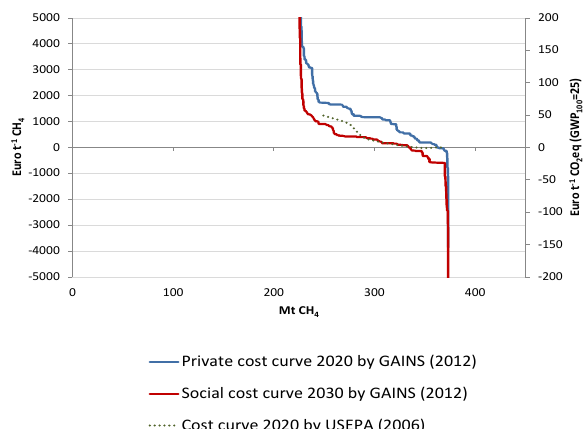
Fig. 6. Global CH 4 mitigation cost curve 2020 with private and so- cial cost perspectives and in comparison to USEPA